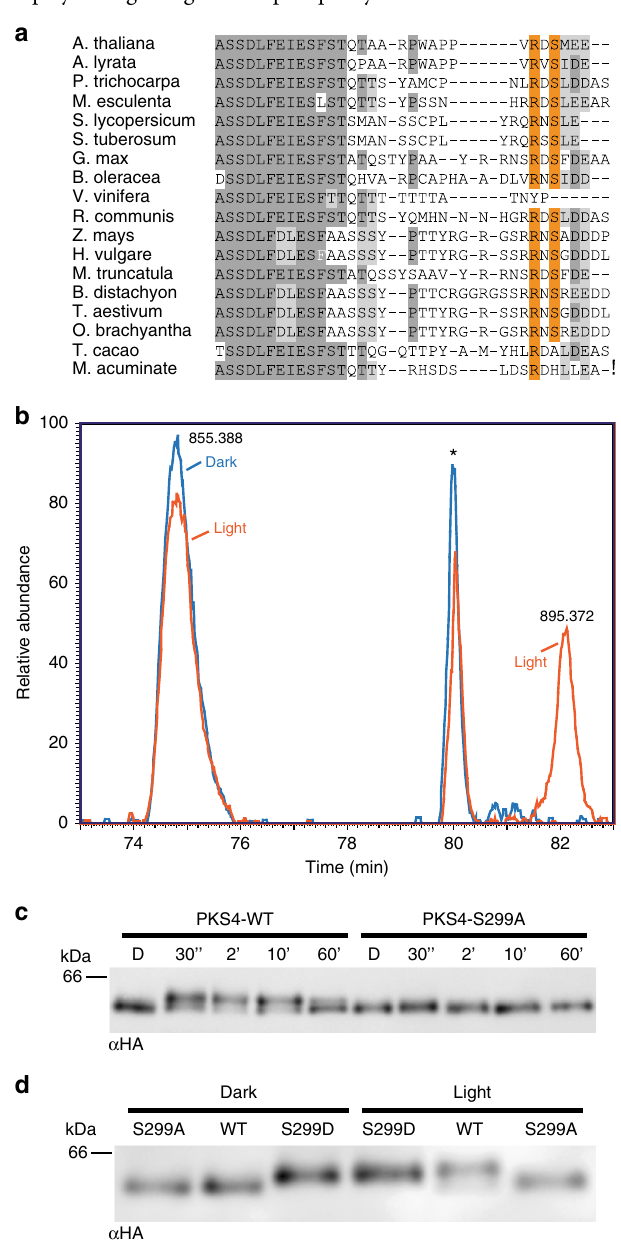
Fig. 1 S299 is required for light-induced PKS4 phosphorylation. a Alignment of PKS4 orthologs from angiosperm. The S299 PKA consensus sequence is highlighted in orange. Identical residues are marked in dark gray, light gray indicates similar residues. b Mass spectrometry analysis of the unphosphorylated (left, m/z : 855.388) and phosphorylated peptide (right, m/z : 895.372) APPVRDSMEETVSEY containing S299 from extracts of dark-grown seedlings (in blue) and light-grown seedlings (in orange). The peak in the middle (marked with an asterisk) is from a different peptide. c Western blot probed with anti-HA antibodies from pks4 PKS4-WT and pks4 S299A samples of etiolated seedlings treated with 15 µ mol m − 2 s − 1 blue light for 0, 2, 10, or 60 min. PKS4D and PKS4L mark the slower and faster migrating isoforms respectively. d Western blot probed as in ( c ) from pks4 PKS4-WT, pks4 S299A, and pks4 S299D samples of etiolated seedlings treated with 150 µ mol m − 2 s − 1 blue light for 30 s or kept